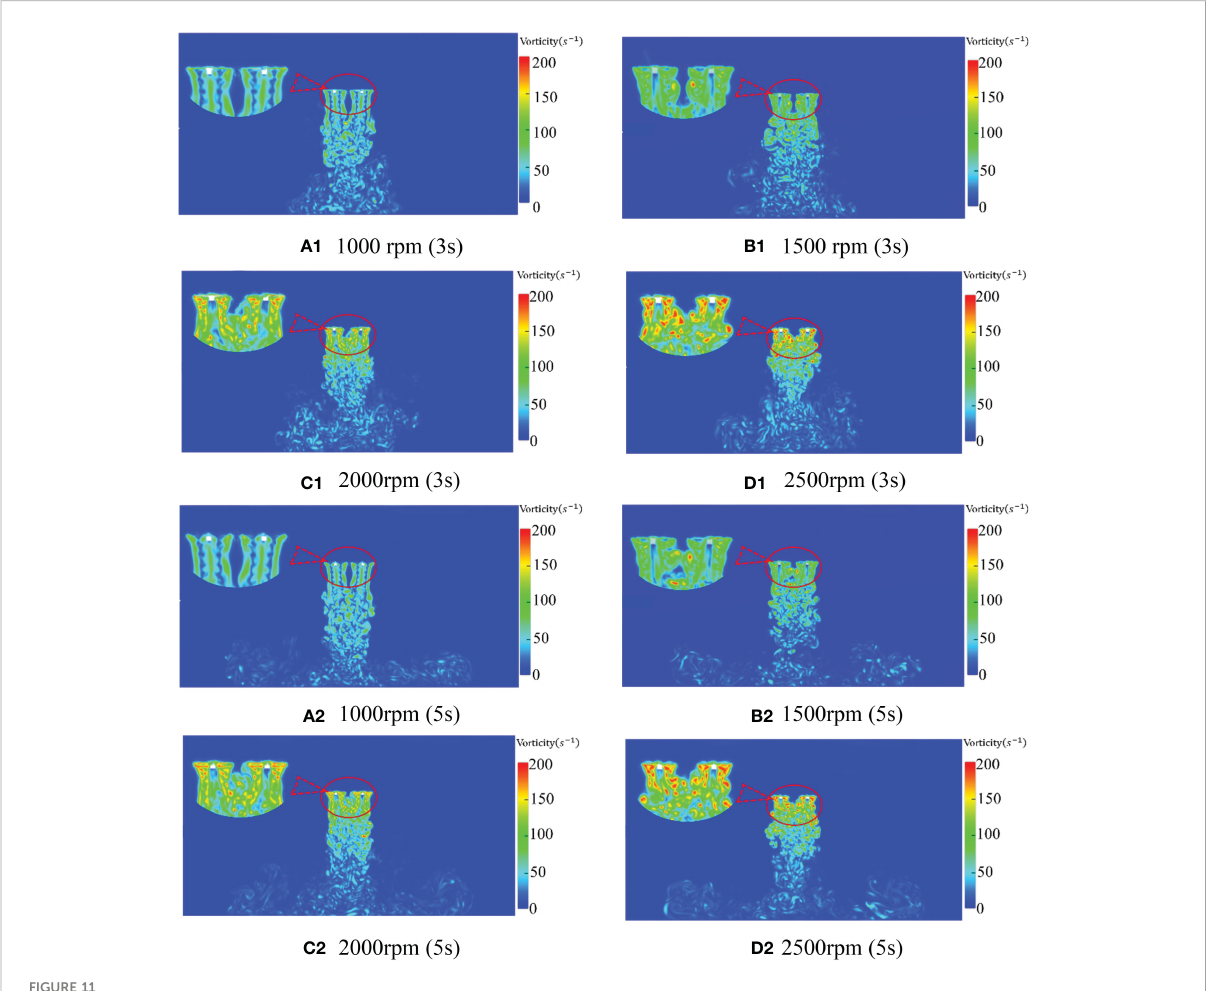
FIGURE 11 Distribution of rotor vorticity at different speeds and different